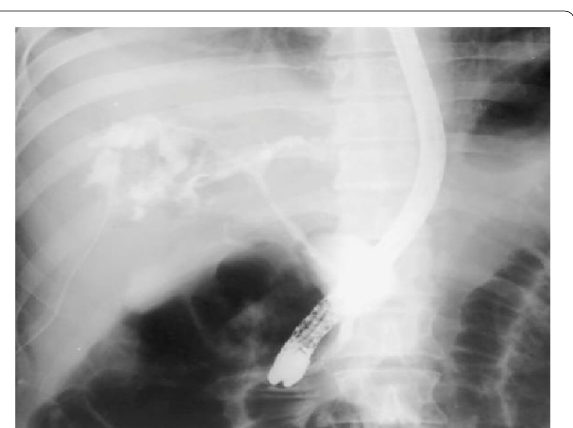
Fig. 5 Extravasation of the contrast into the abscess cavity proofing the linkage with the biliary